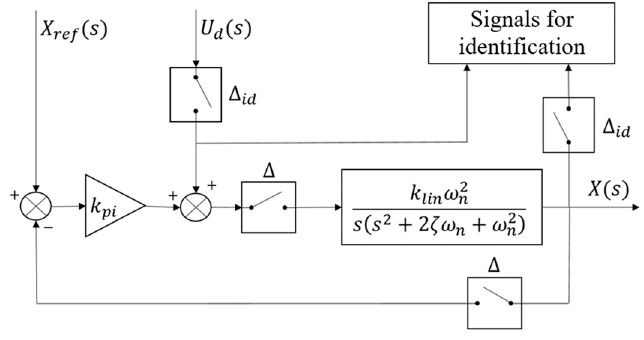
Figure 6. Schematic of the identification.